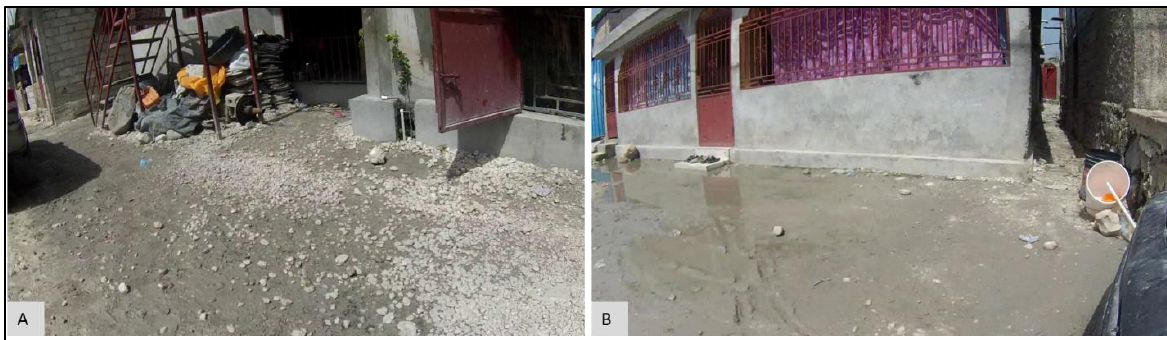
Figure 12. Time-charts for epidemiological variable FC count for: ( A ) M1, ( B ) M13.